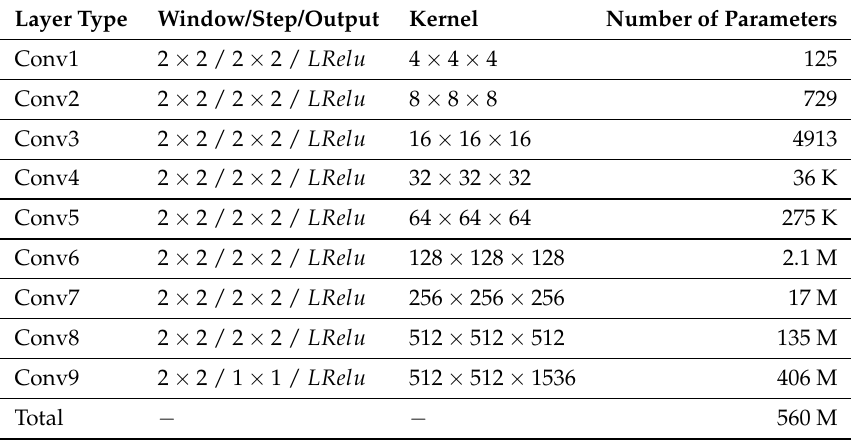
Table 1. Composition of the neural network for localization of